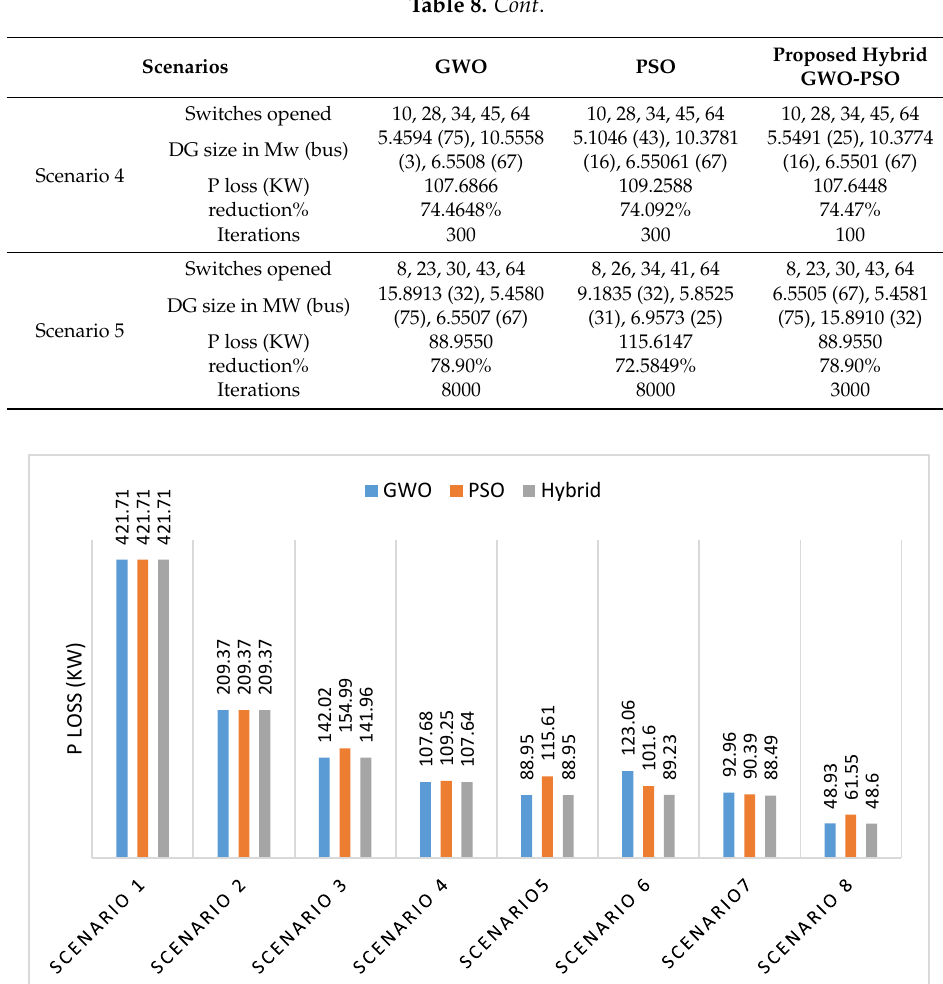
Figure 13. Power loss of the 78-bus system using three different techniques.